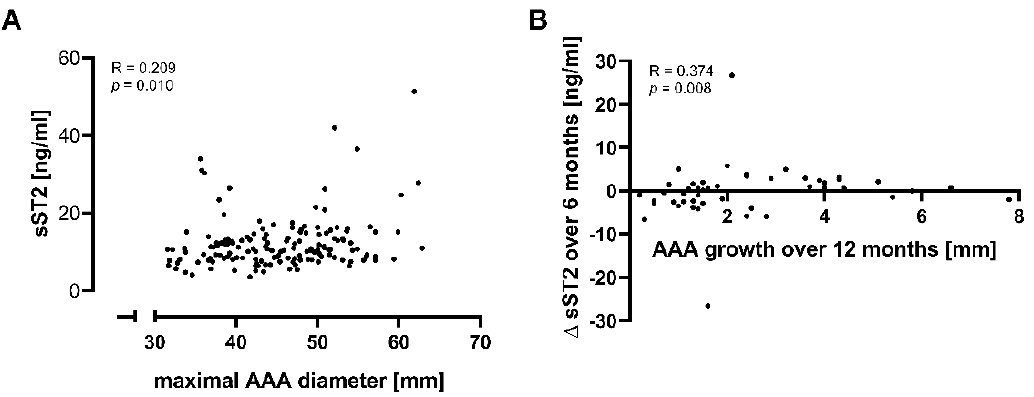
Figure 3. Significant correlations of sST2 concentration and AAA diameter, and their change over time. ( A ) Association between serum sST2 concentrations and maximal AAA diameter. For the prognostic study, circulating sST2 concentrations were longitudinally measured in serum samples from 50 AAA patients at 6-month intervals, resulting in a total of 150 monitoring datapoints. A correlation analysis of sST2 levels and maximal AAA diameter was based on the Spearman correlation coefficient and illustrated with a scatterplot. ( B ) Association between parameter changes. Spearman’s correlation between the change ( ∆ ) in sST2 concentrations over 6 months and the increase in maximal AAA diameter (AAA growth) over 12 months, illustrated by a scatterplot. Abbreviations: sST2, soluble suppression of tumorigenesis 2; AAA, abdominal aortic aneurysm .